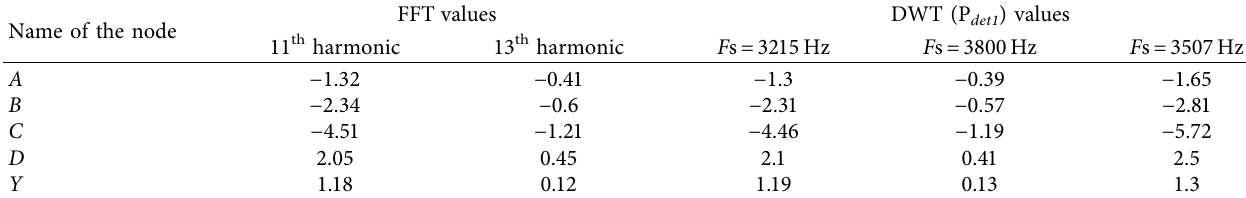
Table 6: The 11th and 13th harmonic current generated by the